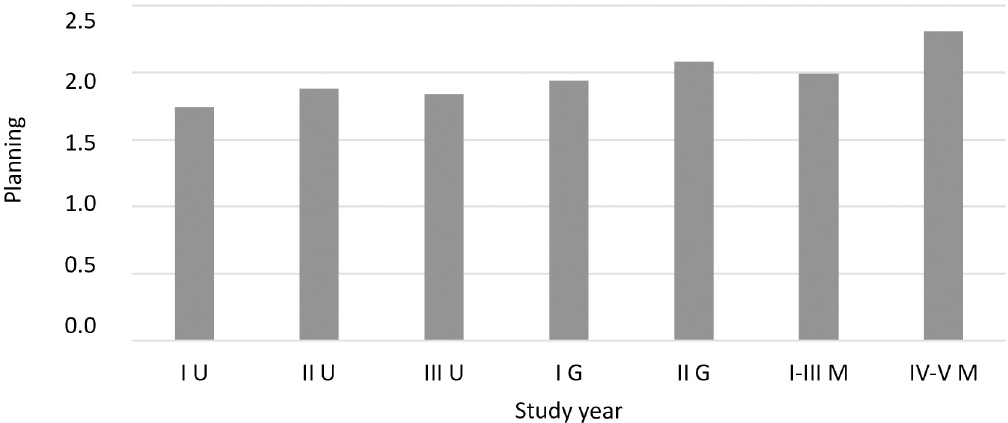
Fig 4. The coping strategy of planning (mean) among students in individual program years (F = 4.87, p < 0.001, eta =